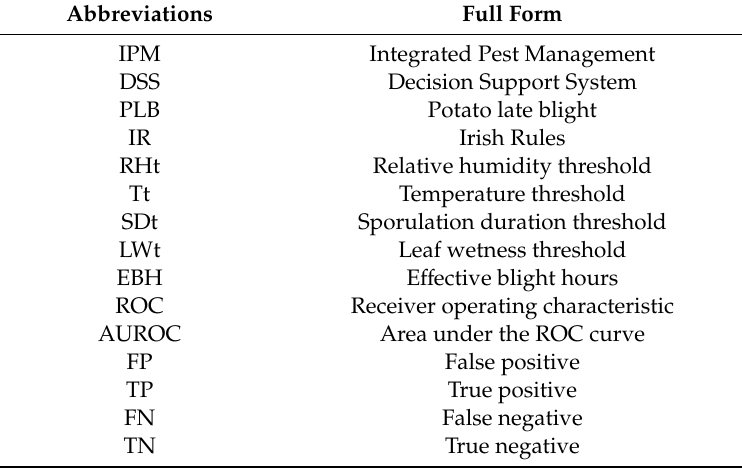
Figure 1. Simplified flowchart of the steps taken in Irish Rules (IR) model evaluation. Table 1. List of frequently used abbreviations in the manuscript along with their full forms.